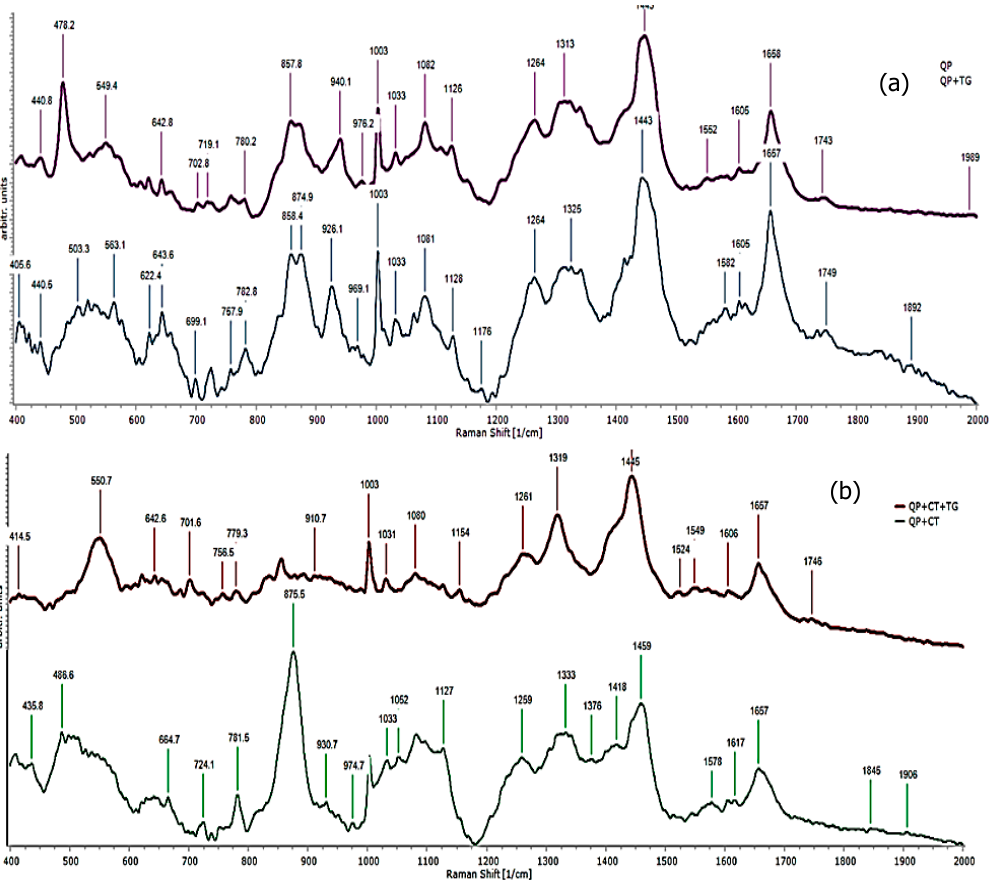
Figure 5. RAMAN spectrogram of QP and CT:QP (1:10, w / w ) films. ( a ) QP and QP + TG; ( b ) CT-QP (1:10, w / w ) and CT:QP (1:10, w / w ) + TG. QP = Quinoa Pasankalla; QW = Quinoa Willd; CT = chitosan; TG = transglutaminase.